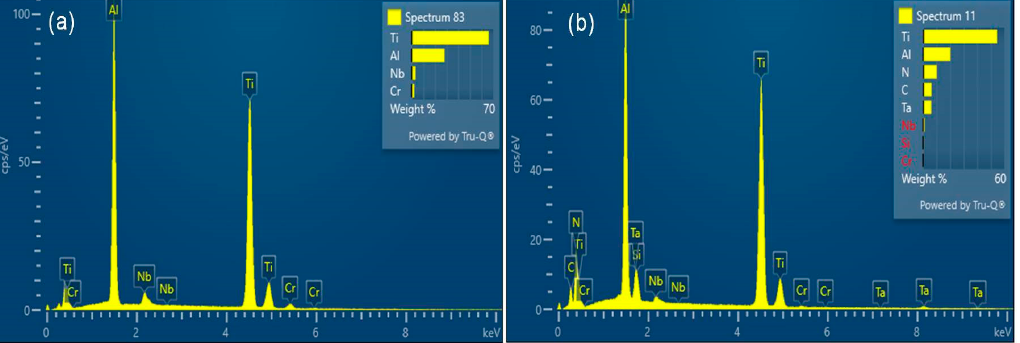
Figure 1. SEM images of sintered samples: ( a ) pure TiAl, ( b ) TiAl − 2 wt.%TaN, ( c ) TiAl − 4 wt.%TaN, ( d ) TiAl − 6 wt.%TaN, ( e ) TiAl − 8 wt.%TaN, and ( f ) TiAl − 10 wt.%TaN.